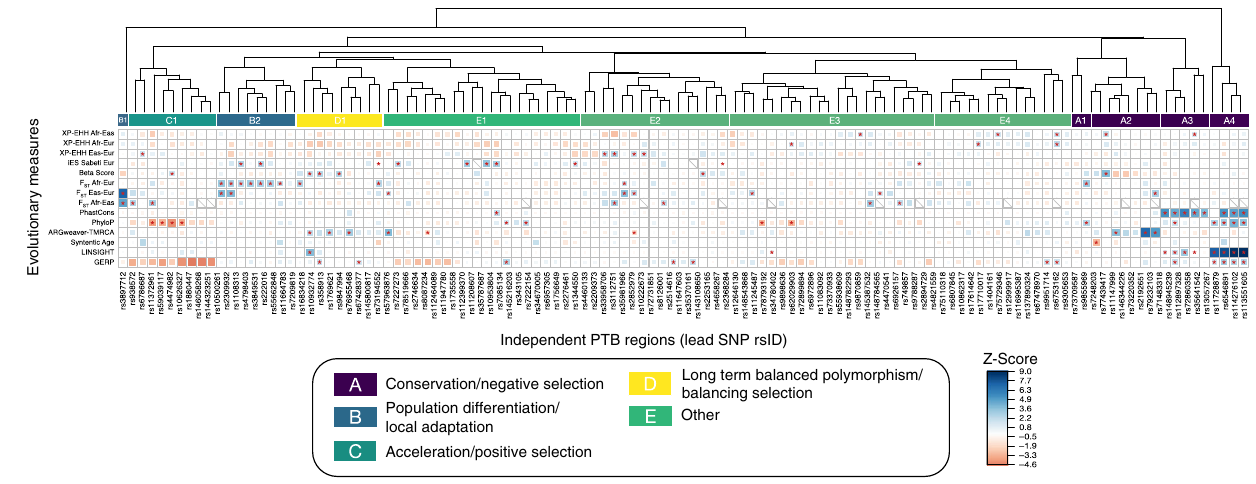
Fig. 2 sPTB-associated genomic regions have experienced diverse evolutionary forces. We tested sPTB-associated genomic regions ( x -axis) for diverse types of selection ( y -axis), including F ST (population differentiation), XP-EHH (positive selection), Beta Score (balancing selection), allele age (time to most recent common ancestor, TMRCA, from ARGweaver), alignment block age, phyloP (positive/negative selection), GERP, LINSIGHT, and PhastCons (negative selection) (Table 1, Fig. 1). The relative strength (size of colored square) and direction (color) of each evolutionary measure for each sPTB- associated region is summarized as a z-score calculated from that region ’ s matched background distribution. Only regions with |z | ≥ 1.5 for at least one evolutionary measure before clustering are shown. Statistical signi fi cance was assessed by comparing the median value of the evolutionary measure to the matched background distribution to derive an empirical p value (* p > 0.05). Hierarchical clustering of sPTB-associated genomic regions on their z-scores identi fi es distinct groups or clusters associated with different types of evolutionary forces. Speci fi cally, we interpret regions that exhibit higher than expected values for PhastCons, PhyloP, LINSIGHT, and GERP to have experienced conservation and negative selection (Group A); regions that exhibit higher than expected pairwise F ST values to have experienced population differentiation/local adaptation (Group B); regions that exhibit lower than expected values for PhyloP to have experienced acceleration/positive selection (Group C); and regions that exhibit higher than expected Beta Score and older allele ages (TMRCA) to have experienced balancing selection (Group D). The remaining regions exhibit a variety of signatures that are not consistent with a single evolutionary mode (Group